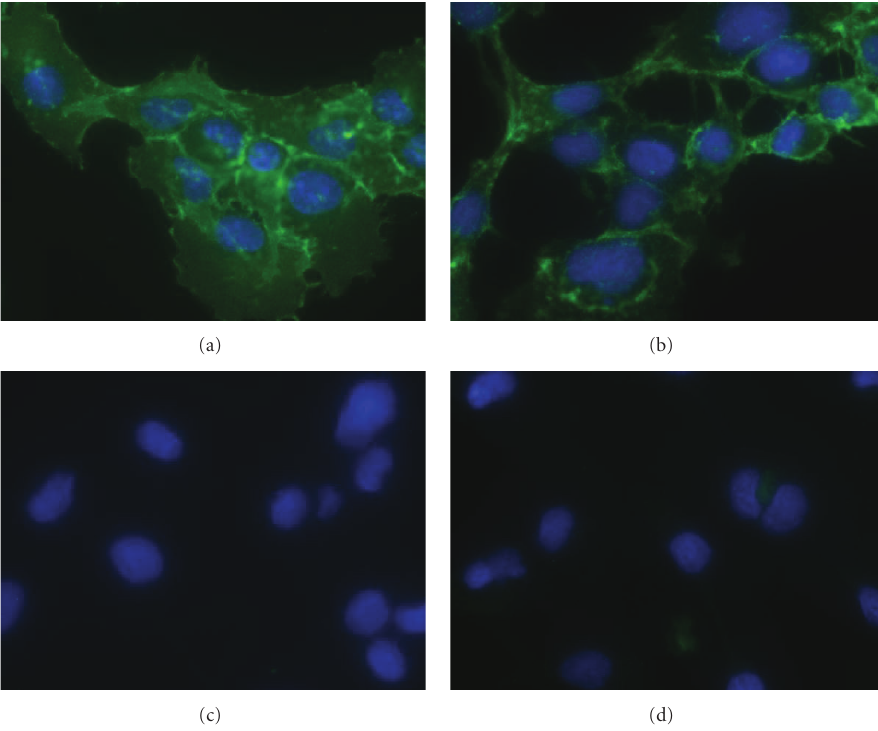
Figure 2: Representative pictures of immunofluorescence staining of β -catenin in tramsformed MSC-TSB cell lines. ((a)-(b)) β -catenin signal (green) was detected in both the cytoplasm and nucleus. ((c)-(d)) Their isotype control counterparts, respectively (63x original